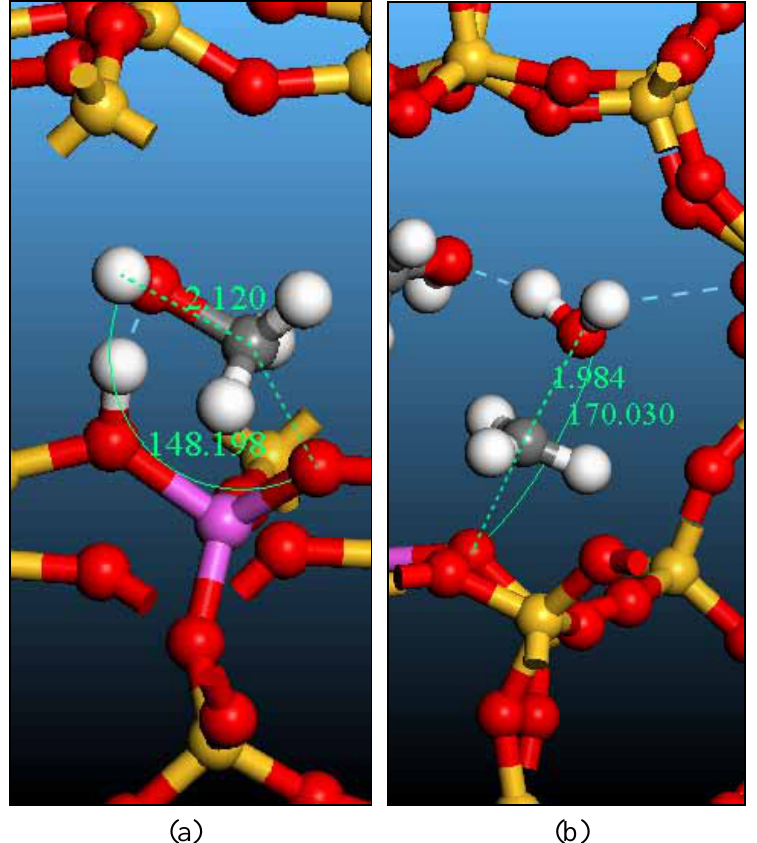
Figure 4. Transition state structures for surface methoxyl formation. (a) One methanol molecule, (b) Two methanol molecules. Dotted lines represent hydrogen